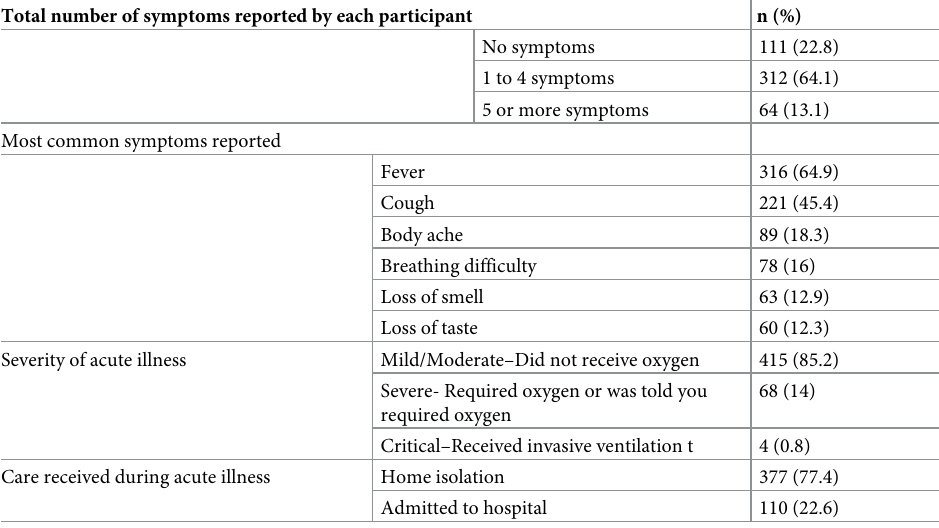
Table 2. Clinical features and management of acute illness of COVID-19 among participants (n = 487). Total number of symptoms reported by each